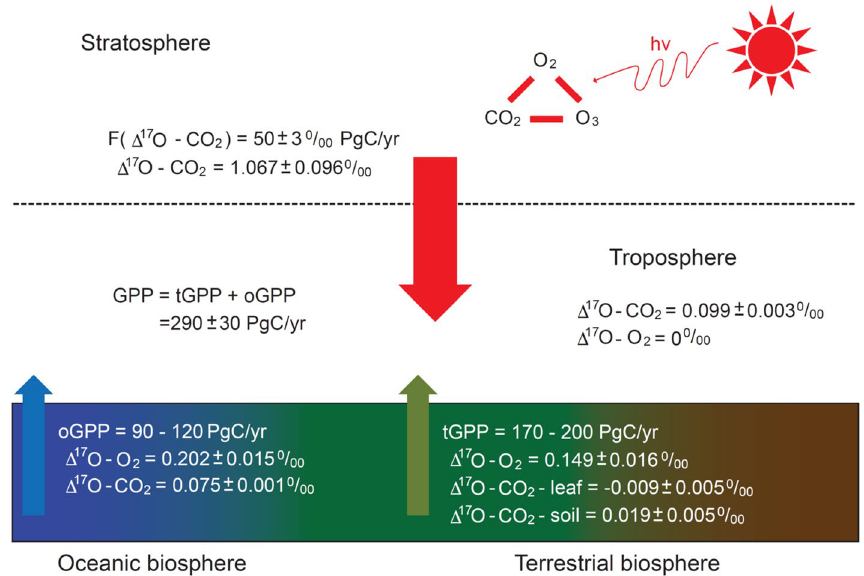
Figure 2. Summary of the budgets of Δ 17 O transport for atmospheric CO 2 and O 2 and gross primary productivities (GPP, tGPP, and oGPP) derived in this